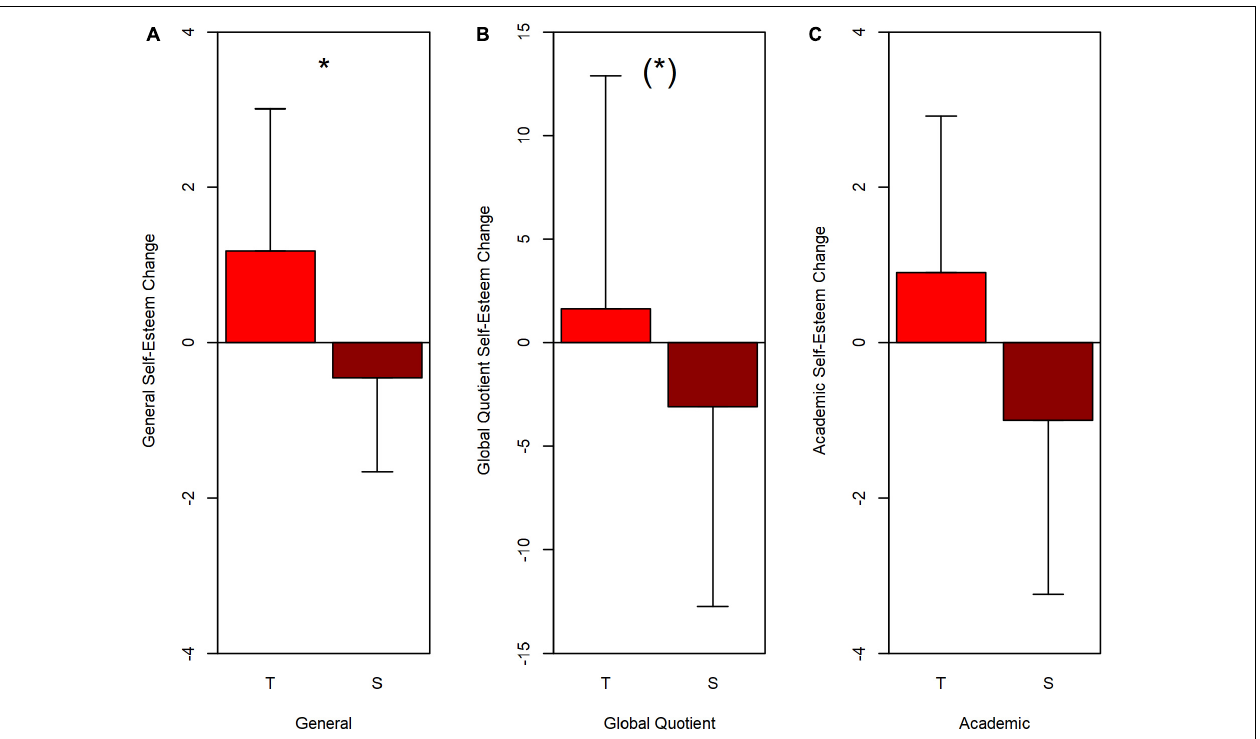
FIGURE 6 | Mean Change scores and standard deviations for three scales of the CFSEI-3, arranged in order of statistical significance between Treatment groups. (A) General subscale; (B) Global Quotient; (C) Academic subscale. T, Turn-taking group; S, Synchrony group. Positive Change scores indicate improved performance. * p = 0.027 in ANOVA. (*) p = 0.073 in Wilcoxon